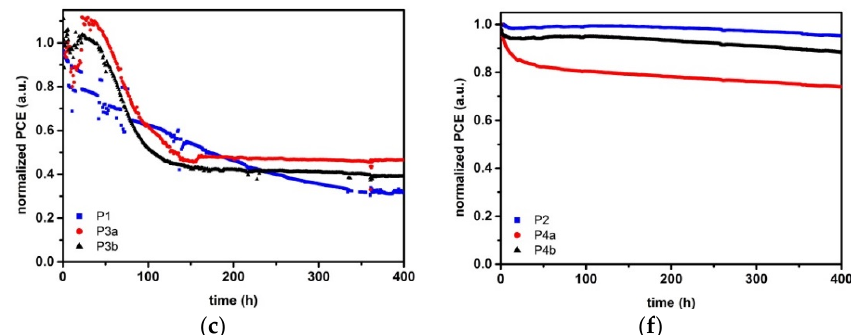
Figure 4. Maximum values of the normalized UV ‐ VIS absorption of the polymer films as a function of time during sun irradiance ( a , d ), average lifetime measurements (ISOS ‐ L ‐ 1 [35]) of the polymer solar cells (PSCs) normalized in terms of PCE ( b , e ) and the thermal degradation test (ISOS ‐ D ‐ 2 [35]) of the PSCs normalized in terms of PCE ( c , f ) for the BT ‐ ( a – c ) and TzTz ‐ ( d – f ) based polymer series.